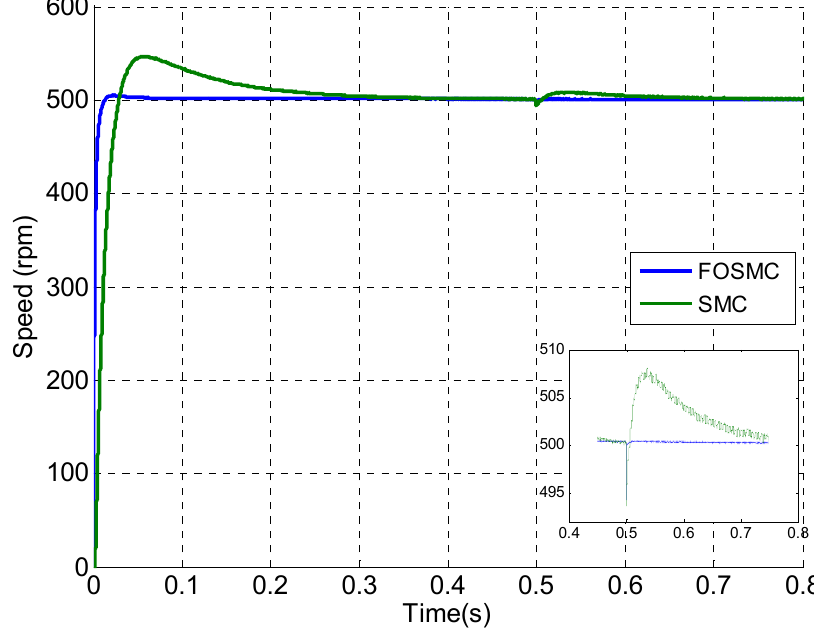
Figure 4. Speed response of the proposed FOSMC and conventional SMC speed controller.